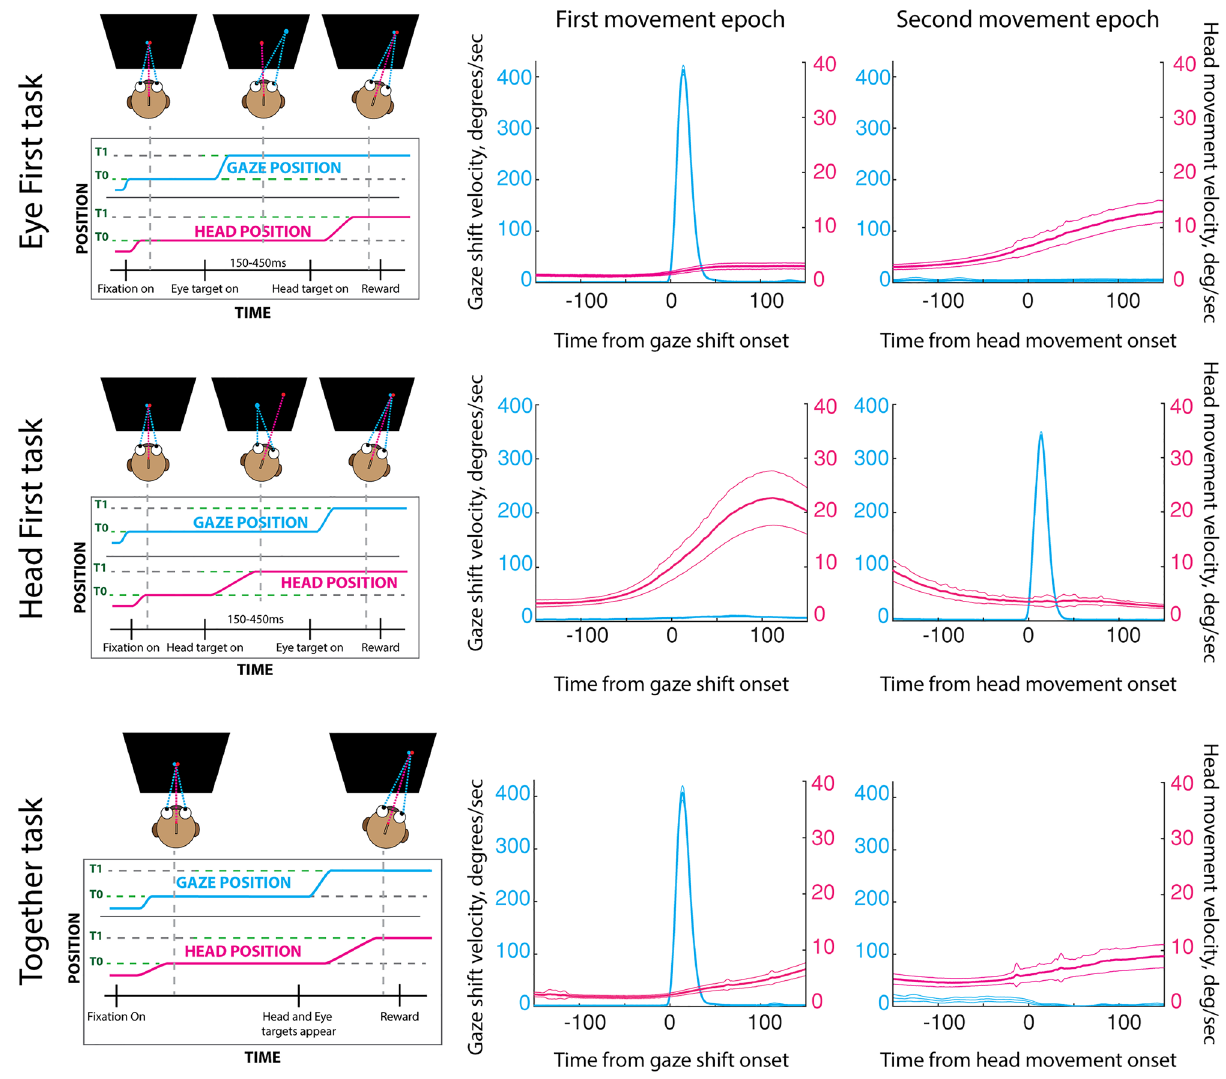
Figure 1. Task types performed by the animal. Top row: eye-first task. The animal was instructed to move the eye to a target location while keeping the head motionless. After a variable delay time, the animal had to orient the head to the same location as the gaze. Visual feedback of instantaneous head position was provided through a cursor on the screen. Middle row: head-first task. The animal first pointed its head to a target in the periphery by using the cursor feedback. After a variable delay the animal shifted its gaze to the same target. Bottom row: together task type. The animal aligned both head and gaze positions to a peripheral target. In this task the animal was not constrained in how he chose to complete the trial successfully. Feedback on head position was also provided for this condition. For each row, the middle and right panels show the average (over all sessions) gaze and head movement velocities during their movement epochs. Time is referenced in milliseconds. The thin lines are two standard errors from the